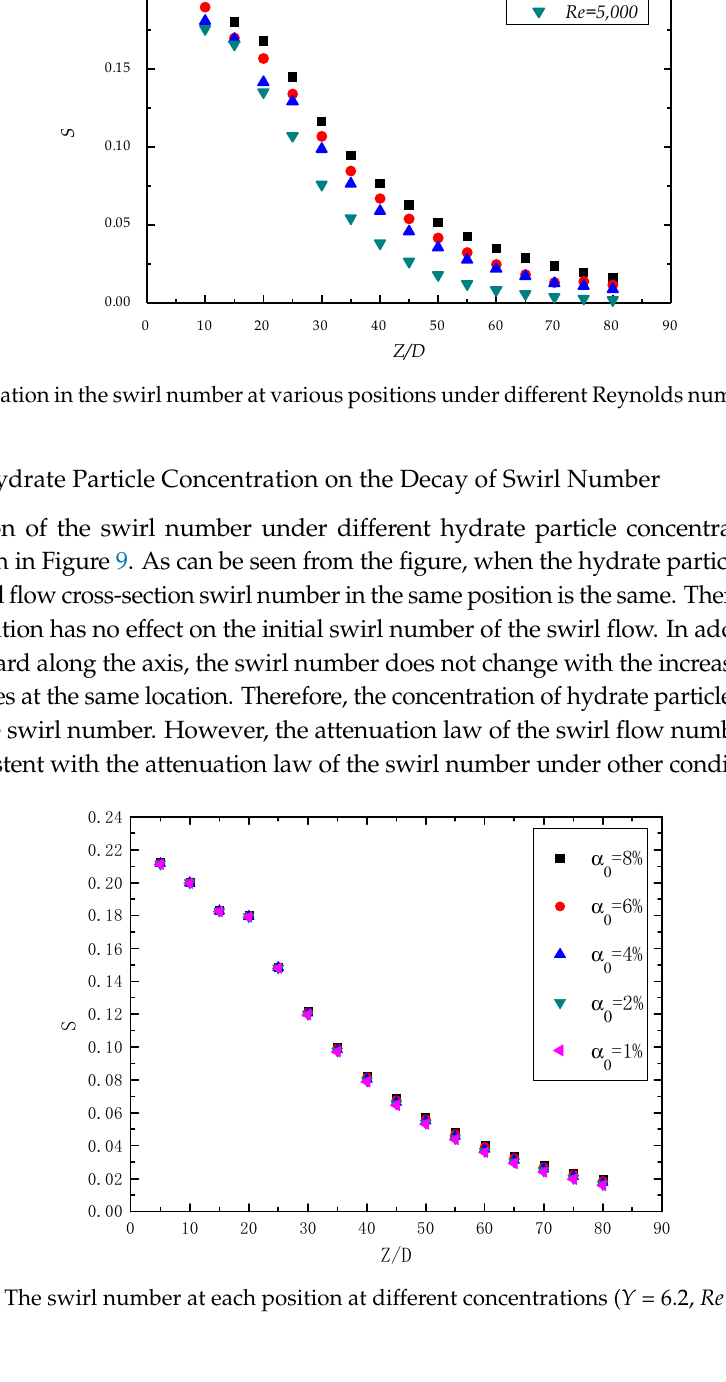
Figure 7. The swirl number at each position under different twist rates ( α 0 = 2%, Re = 20,000).